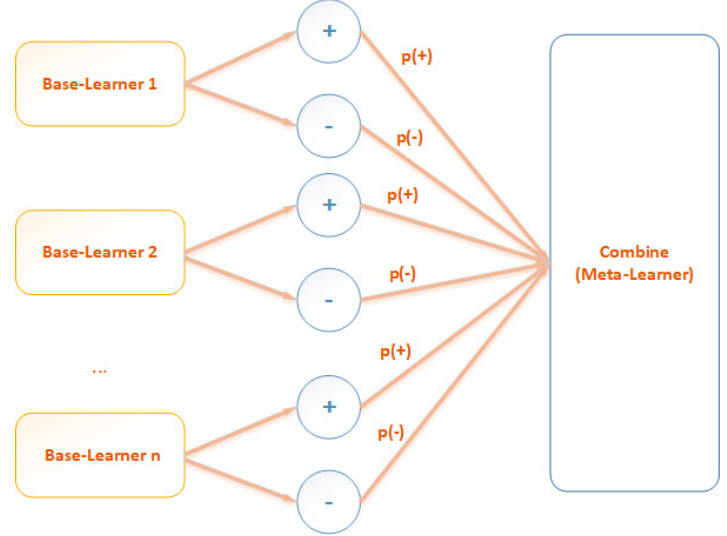
Figure 4. Ensemble learning using Meta-Classifier model.